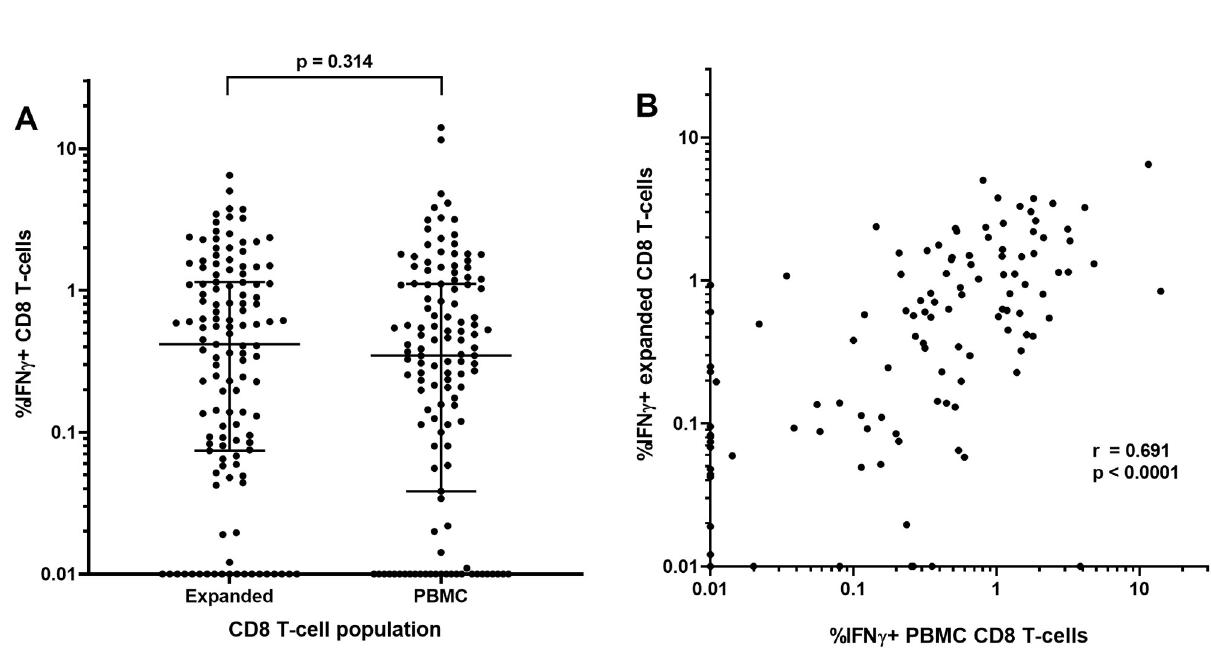
Fig 3. Flow cytometric analyses of IFN γ + events of CD3+CD8+ T-cells stimulated with CMVpp65 or HIV-1 PTE peptide pools in expanded CD8 T-cells or PBMC. A) percent IFN γ + events with medians (bar) and interquartile ranges and B) correlation between datasets with a non-parametric Spearman test used to compute the correlation coefficient (r) between the two datasets. For log 10 scale display only, values of < 0.01 SFU were assigned a value of 0.01. Statistical analyses were conducted using unaltered data.